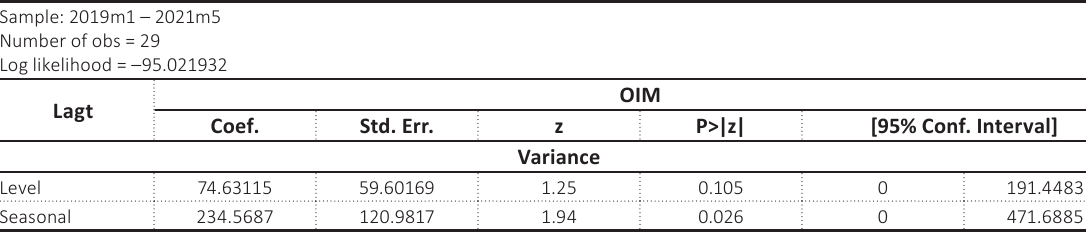
Table 3. Stata output from fitting the first unobserved-components